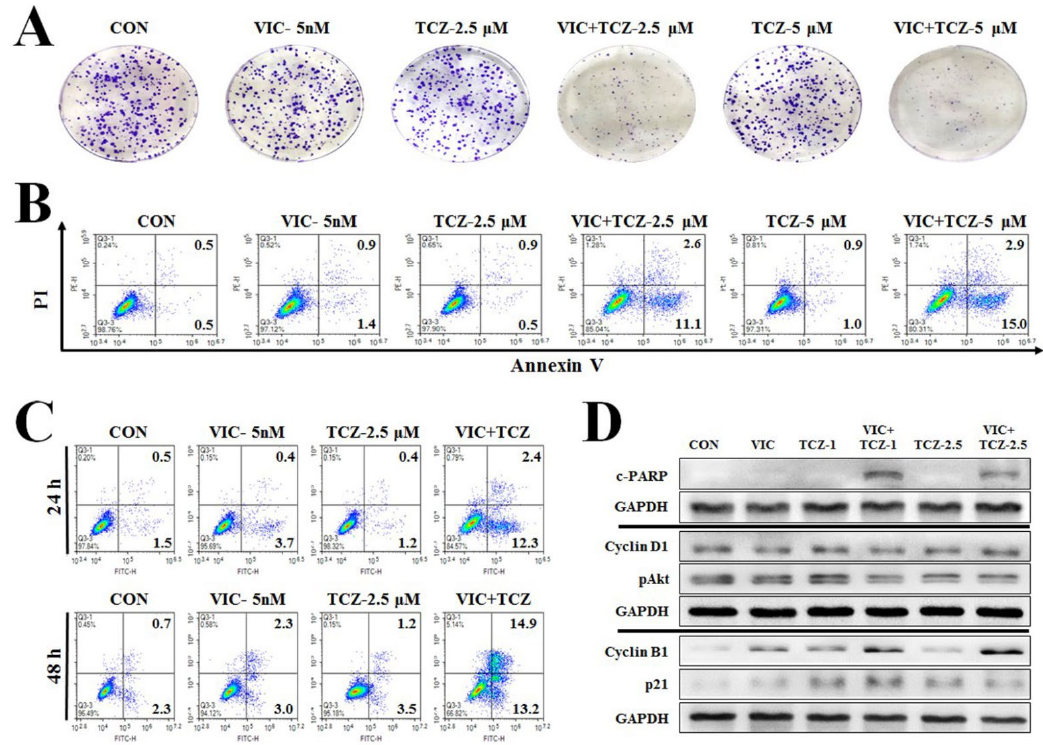
Figure 2. TCZ increases apoptosis in VIC-treated KBV20C cells. ( A ) KBV20C were treated for three days with 5 nM VIC, the indicated µ M concentrations of TCZ alone, or in combination with 5 nM VIC, or 0.1% DMSO (CON). Colony-forming assays were immediately measured with crystal violet staining after total 10 days. ( B ) KBV20C cells were treated with 5 nM VIC, the indicated µ M concentrations of TCZ alone, or in combination with 5 nM VIC, or 0.1% DMSO (CON). After 24 h, annexin V analyses were performed as described in Materials and Methods. ( C ) KBV20C cells were treated with 5 nM VIC, 2.5 µ M TCZ alone, or in combination with 5 nM VIC, or 0.1% DMSO (CON). After 24 h or 48 h, annexin V analyses were performed as described in Materials